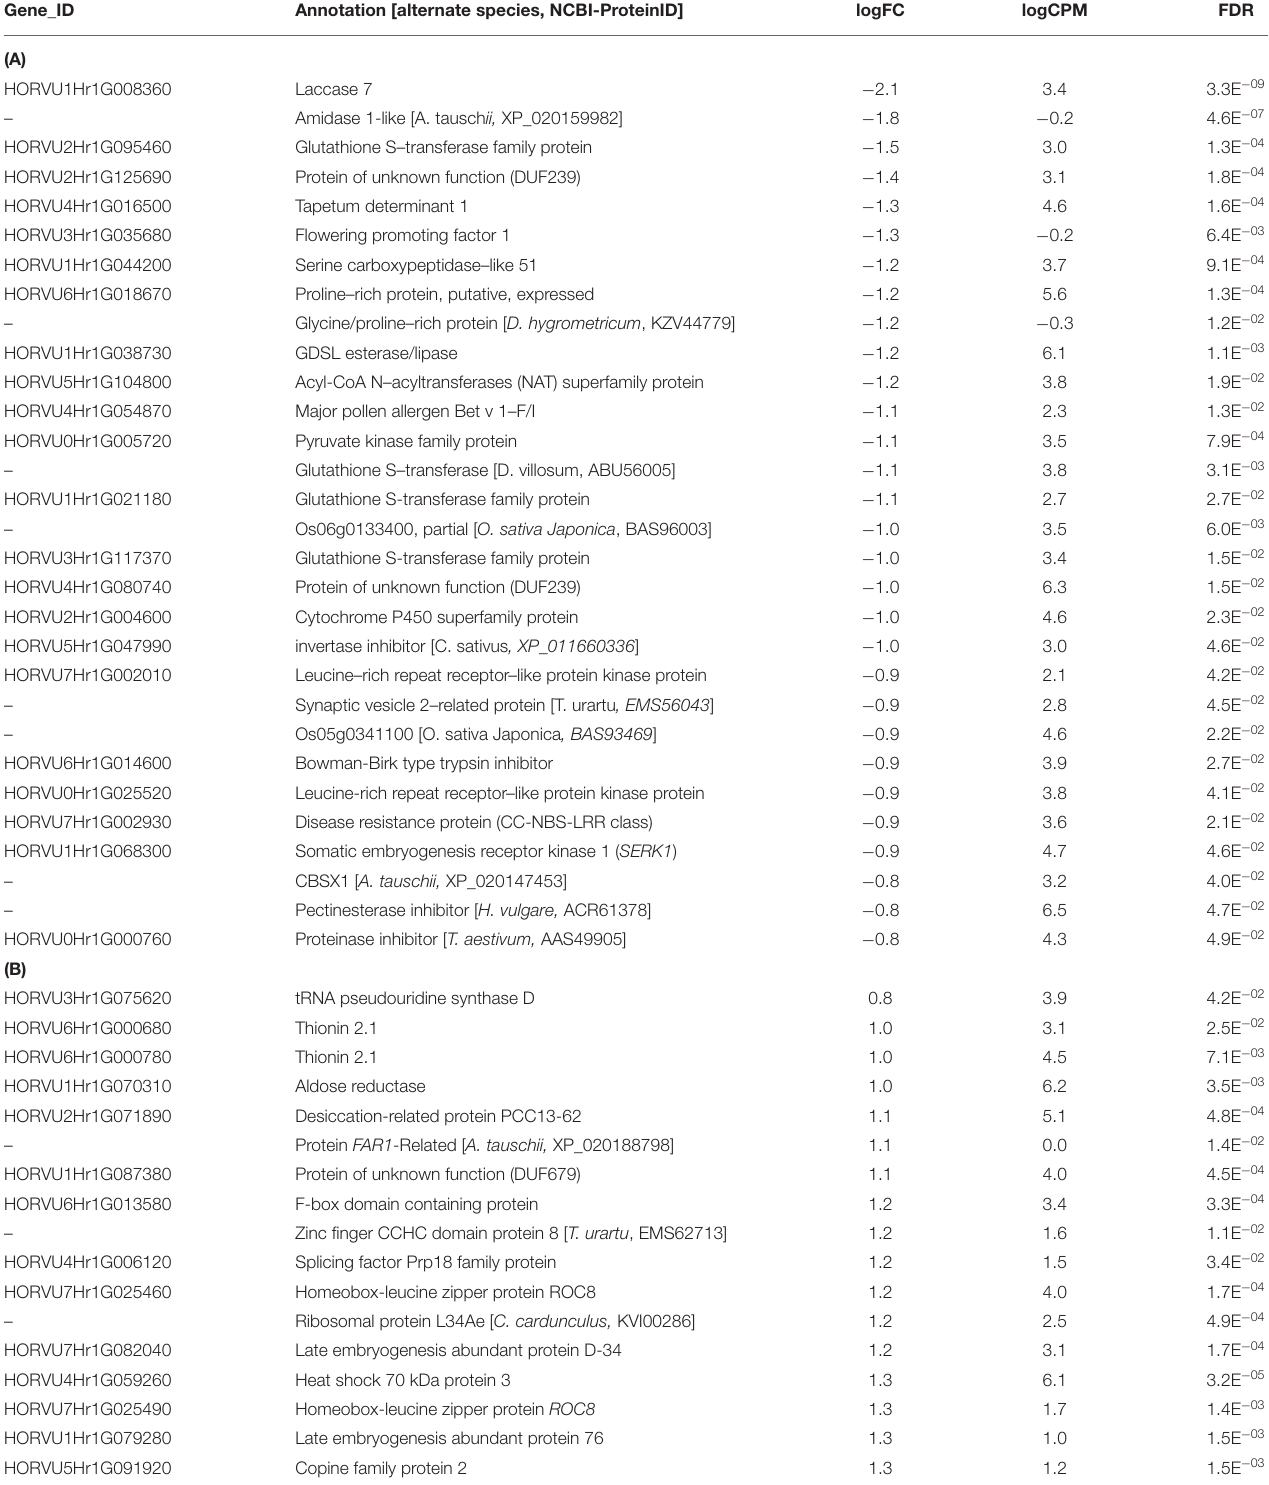
TABLE 4 | (A) Transcript alterations in genes differentially expressed in “CDC Kendall” identified in the additive, interactive generalized linear model. (B) Transcript alterations in genes differentially expressed in “Norman” identified in the additive, interactive generalized linear